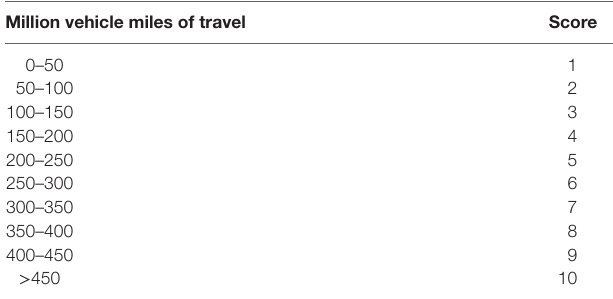
TaBle 3 | Amount of travel scoring scheme.